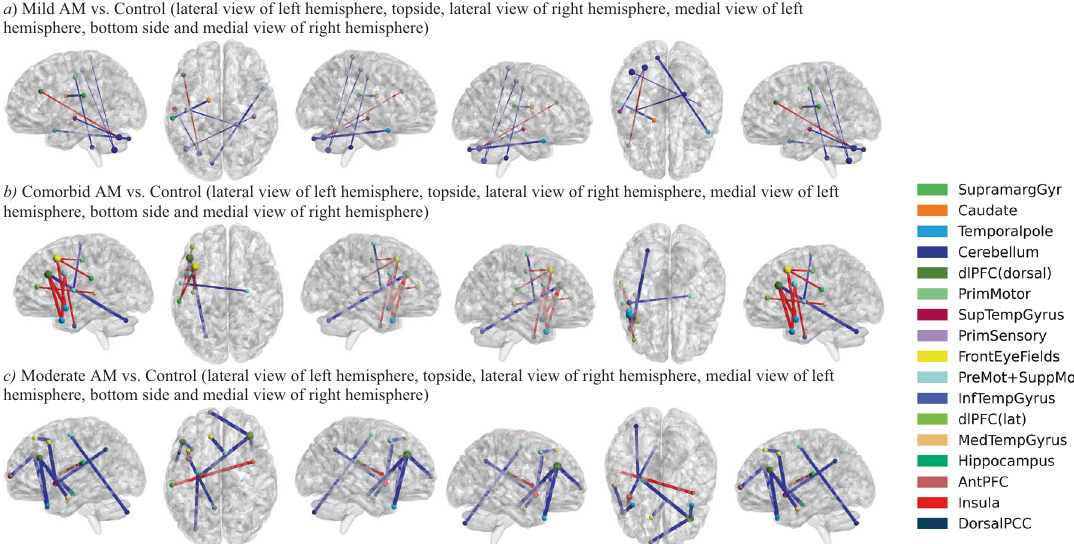
Fig. 3 Top FC features differentiating each of the mild AM biotype (a), comorbid AM biotype (b) and moderate AM biotype (c) from control subjects. FC features used in the cluster analysis were considered. All FC features ( n = 7) that differed signi fi cantly (Wilcoxon rank-sum tests, P < 0.05, Bonferroni corrected) between mild AM and control groups and the top-10 features that differed most signi fi cantly between the other two biotypes from controls were listed. ROIs were colored according to the Brodmann area they belong to, and node size was scaled by its node degree. The edges were colored according to the feature effects: red: AM biotype > control, on average; blue: AM biotype < control, on average. The edge thickness corresponded to the negative-logged P -value. Detailed information about FC features in a , b and c can be found in Supplementary Table